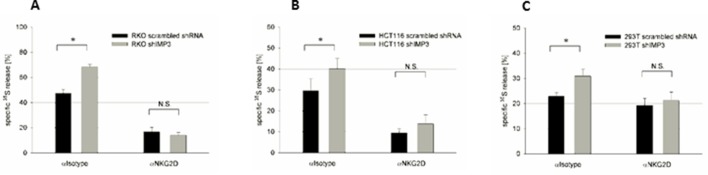
Knockdown of IMP3 enhances NK cell-mediated killing of cancer cells in a NKG2D dependent manner.(A-C) Primary human NK cells were incubated with an isotype antibody (left columns, αIsotype) or with anti-hNKG2D monoclonal antibody (right column, αNKG2D) for one hour on ice before target cells – either transduced with a control shRNA or shIMP3 – were added. 35S released into the supernatant upon target cell lysis by NK cells, was assessed 3 hr later (A) 35S release by RKO cells co-cultured with NK cells in the ratio 1:25. *p=0.023 in student’s t-test. (B) 35S release by HCT116 cells co-cultured with NK cells in the ratio 1:10. *p=0.001 in student’s t-test. (C) 35S release by 293T cells co-cultured with NK cells in the ratio 1:10. *P=0.013 in student’s t-test. All experiments were performed at least twice and one representative replicate is shown.